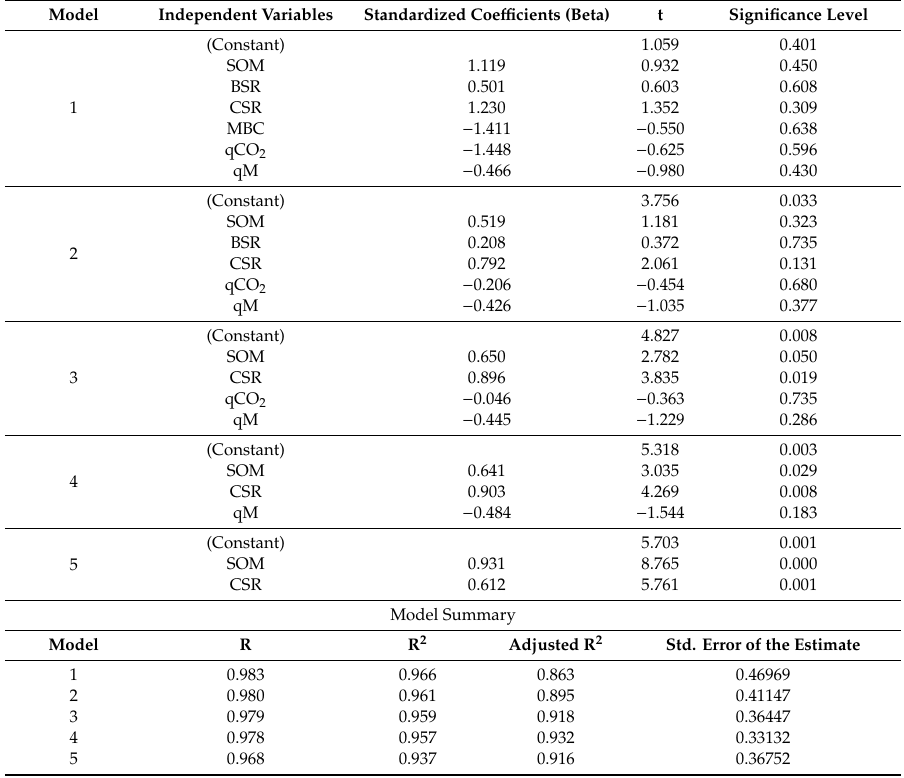
Table 6. Multiple linear regressions (backward method) among BFI (dependent variable) and six biological variables (independent variables) under three land